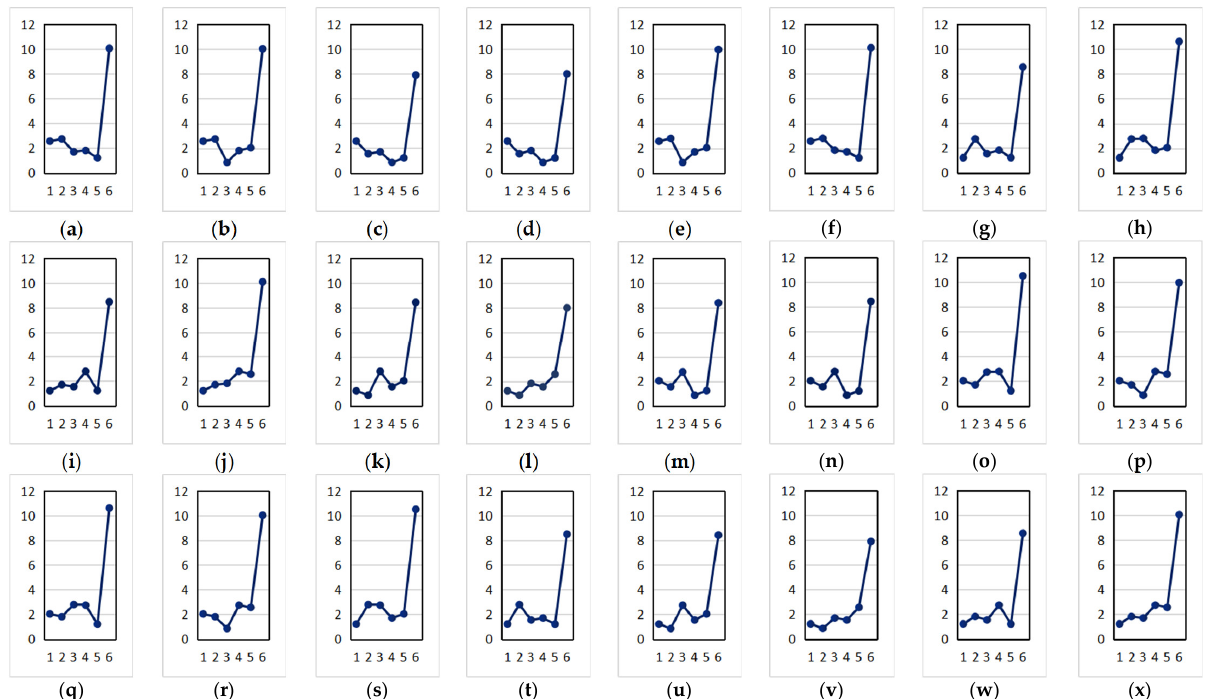
Figure 12. The increasing tendency of the weight of each tour route tourist attraction adjacency section Z o ( R to ( i ) , R to ( j ) ) under the condition of transportation mode of using a taxi. The figure ( a – x ) represent the No.1~No.24 tour routes shown in the Table 6 under the condition of transportation mode of using a taxi τ = 2.